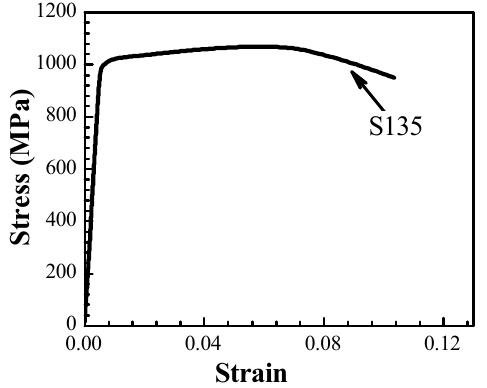
Figure 4. Stress–strain curve of S135 steel.